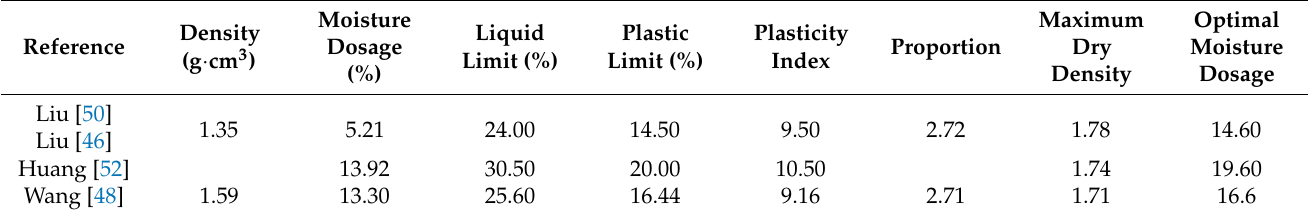
Table 1. Basic properties of trial loess.